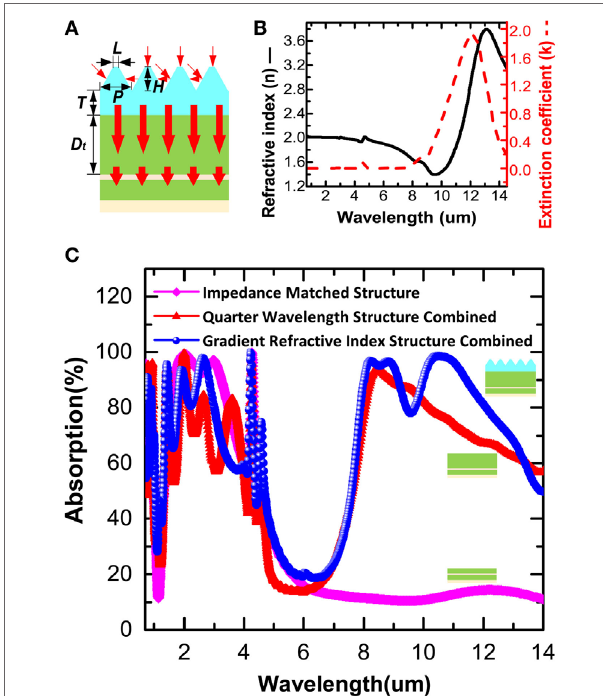
FigUre 3 | (a) Schematic of the light propagation in the hierarchical structure. (B) Measured optical constants of the SiO 2 layer deposited by the plasma-enhanced chemical vapor deposition method at room temperature. (c) Simulated absorption properties of the integrated IM + QW structure and the finial optimized hierarchical